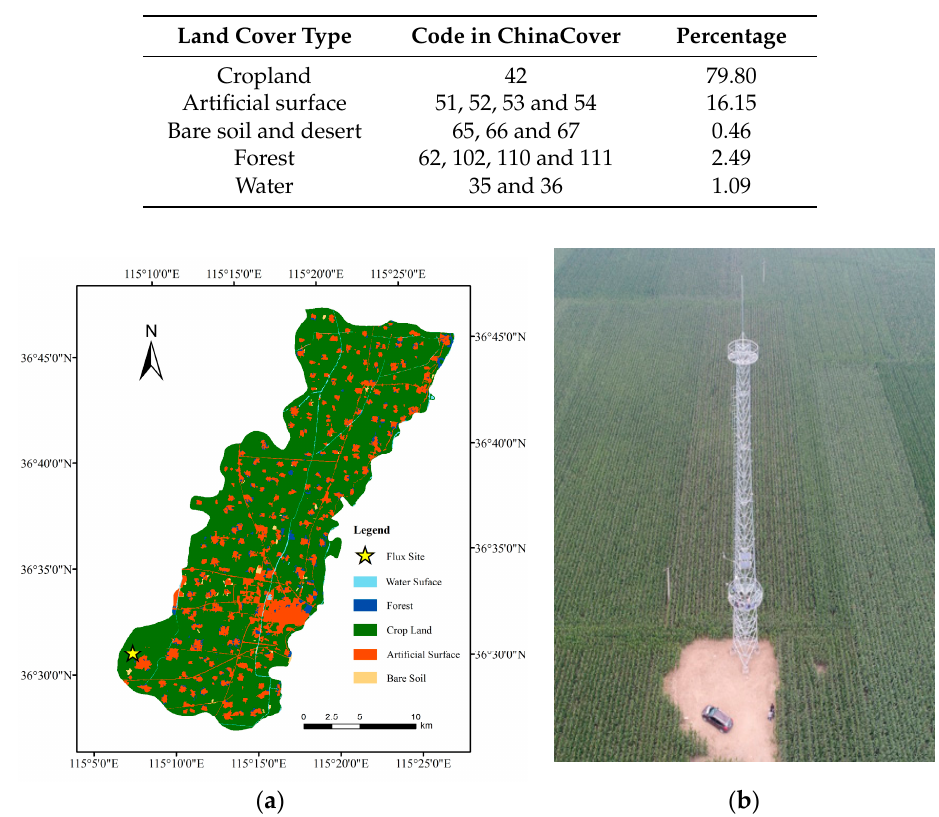
Figure 2. ( a ) land cover map of Guantao County, ( b ) photograph of the EC tower.